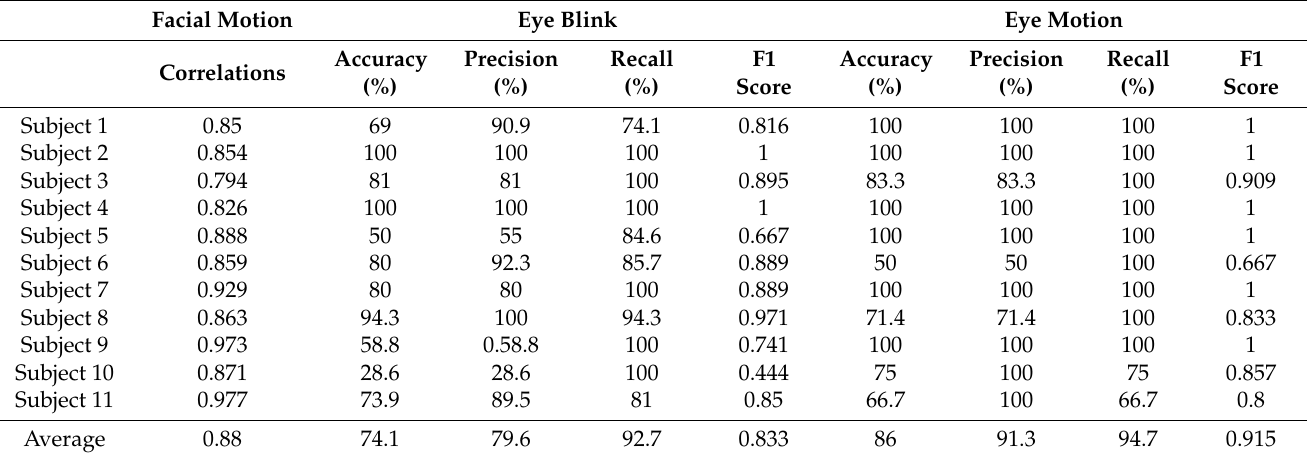
Table 3. Correlation between real and avatar facial motions and accuracy, precision, recall, and F1 score of eye blinks and eye